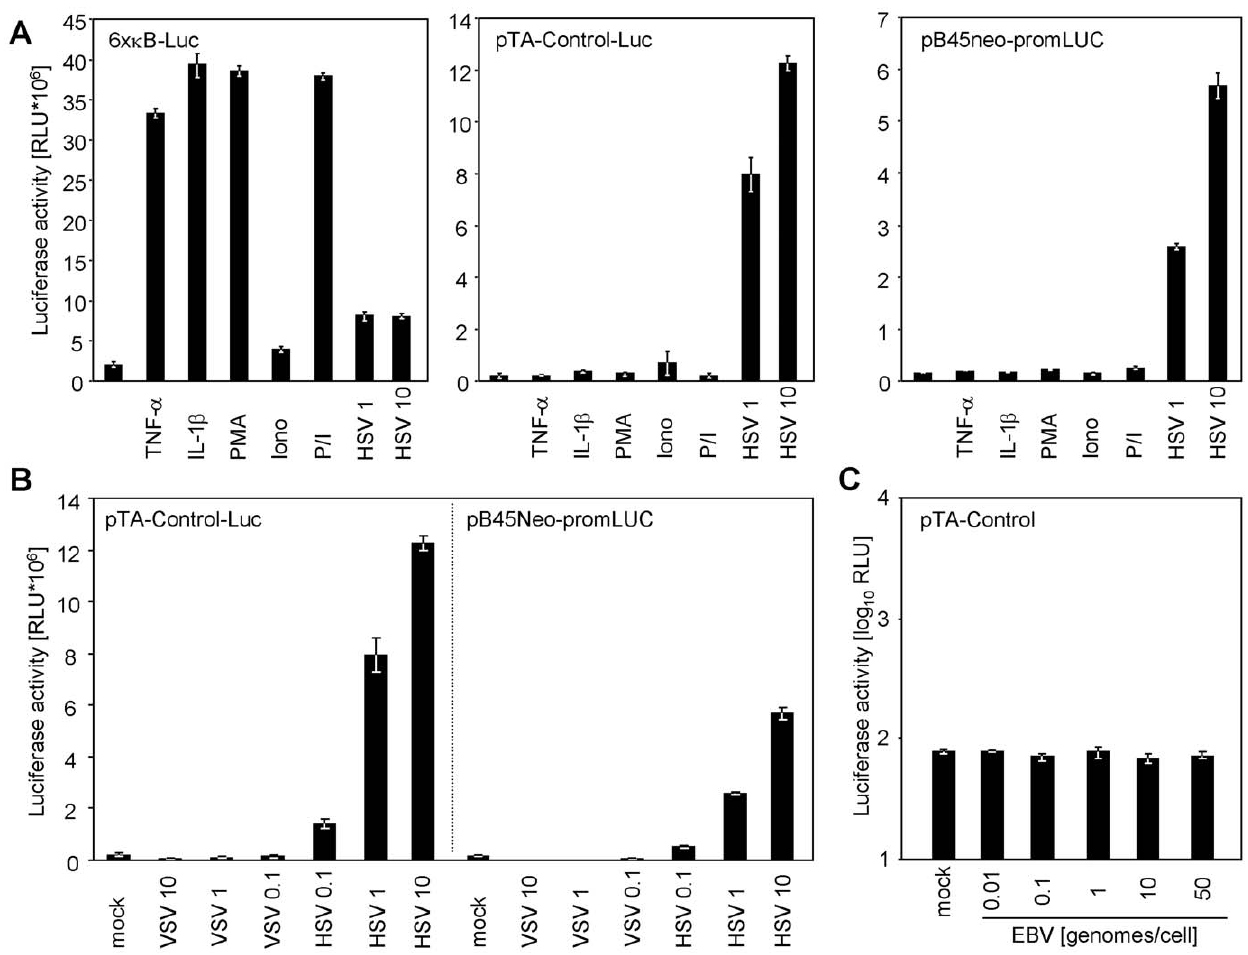
Figure 3. Specificity of responsiveness of the pTA-Control and the pB45Neo-promLUC construct. ( A ) HeLa cells were transiently transfected with 2 m g of the ‘6 6 k B-Luc’ NF- k B-reporter construct, the pTA-Control or the pB45Neo-promLUC. 16 h later cells were treated with 20 ng/ml tumour necrosis factor (TNF)- a , 5 ng/ml interleukin (IL)-1 b , 0.1 m g/ml phorbol-12-myristate-13-acetate (PMA) or 1 m g/ml ionomycin (Iono) or both (PMA/Iono) for 4.5 h. A 16 h infection with 10 or 1 PFU/cell HSV-1 F strain (HSV 1 and HSV 10, respectively) served as control for inducibility by herpes viruses. ( B ) HeLa cells were transiently transfected with the pTA-Control or the pB45Neo-promLUC construct and infected with 0.1, 1 or 10 TCID50 vesicular stomatitis virus (VSV) and 0.1, 1 or 10 PFU/cell HSV-1 F strain, respectively. 15 h later cells were lysed and luciferase activity was measured. ( C ) 10 6 RPMI8866 cells were transfected with 2 m g of the pTA-Control construct and infected over night with the indicated EBV genome copies/cell. Cells were lysed and luciferase activity was